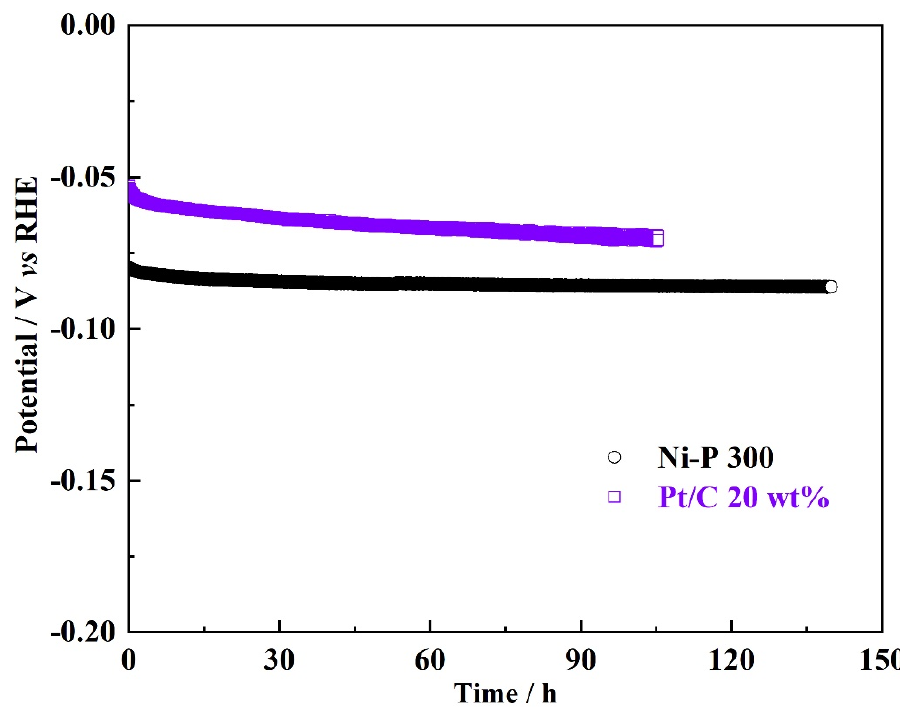
Figure 8. Chronopotentiometric curves of the Ni-P 300 and commercial 20 wt% Pt/C recorded at a constant current density of 10 mA cm − 2 .